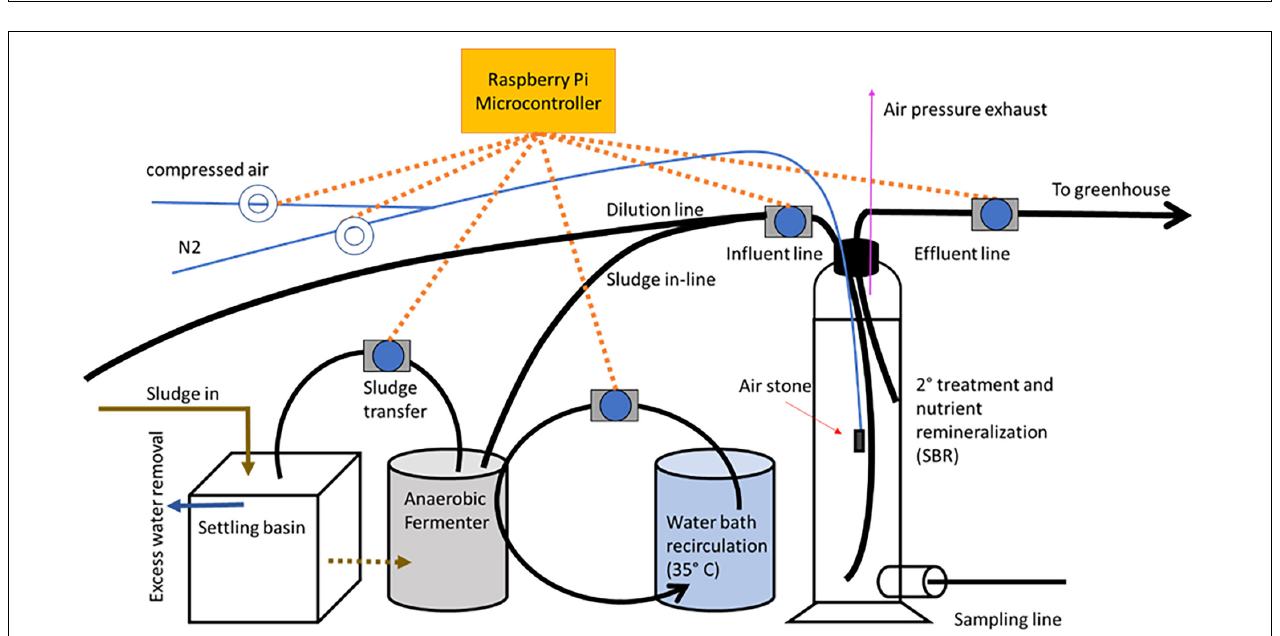
FIGURE 1 | Schematic plan of the three parallel recirculating aquaculture system (RAS) units (left) and greenhouse (right). Blue arrows represent the transfer of wastewater toward the greenhouse, brown arrows represent the transfer of fish solids through the solids treatment pipeline, purple arrows represent the return flows from the greenhouse. Treatments were randomly assigned to their respective gutters.